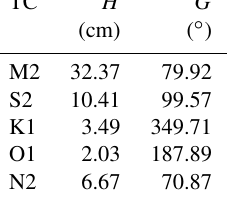
Table 3. Amplitudes ( H , cm) and Greenwich phase lags ( G , ◦ ) of the main tidal constituents (TCs) in the STHL2 set. TC